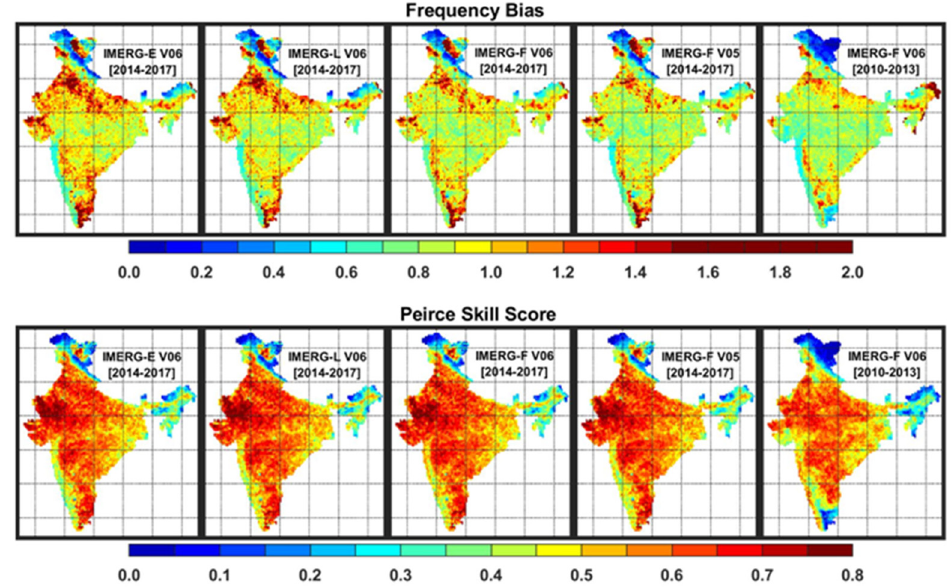
Figure 10. Spatial distributions of frequency bias index and Peirce skill score in the detection of rainy days from the IMERG estimates as compared to the rain-gauge-based data over India for the GPM (2014–2017) and pre-GPM (2010–2013) periods.